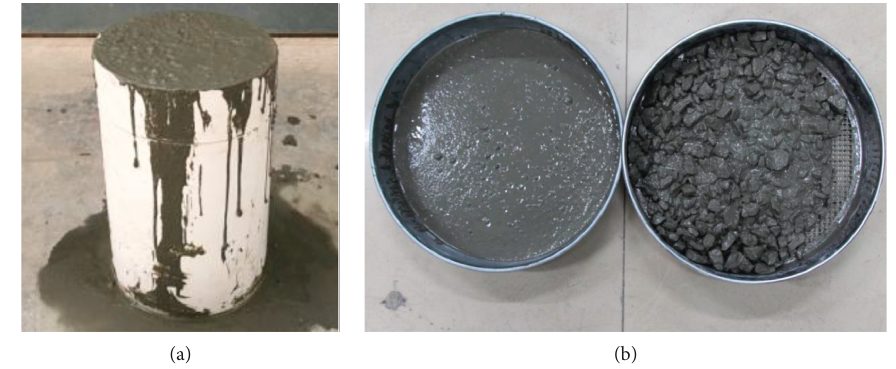
Figure 9: Column segregation test.